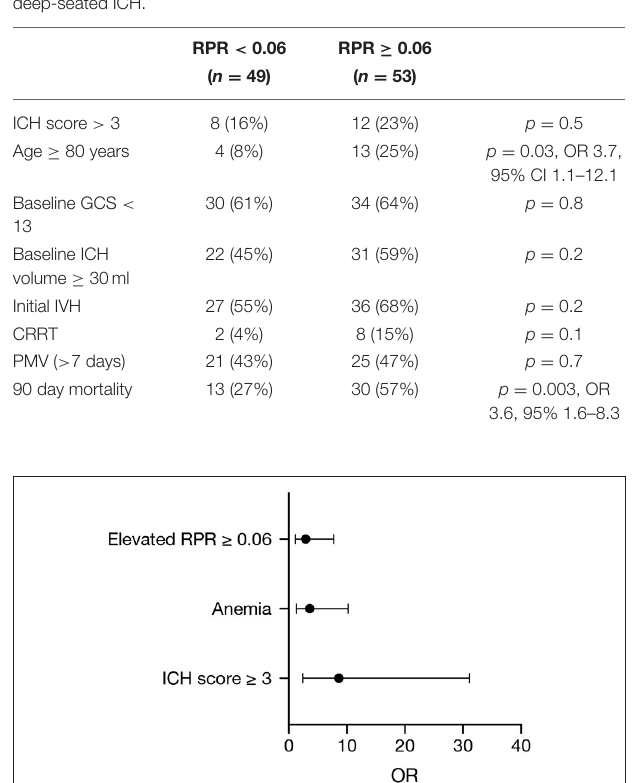
TABLE 1 | Patient characteristics. TABLE 2 | Distribution of known prognostic factors in patients with